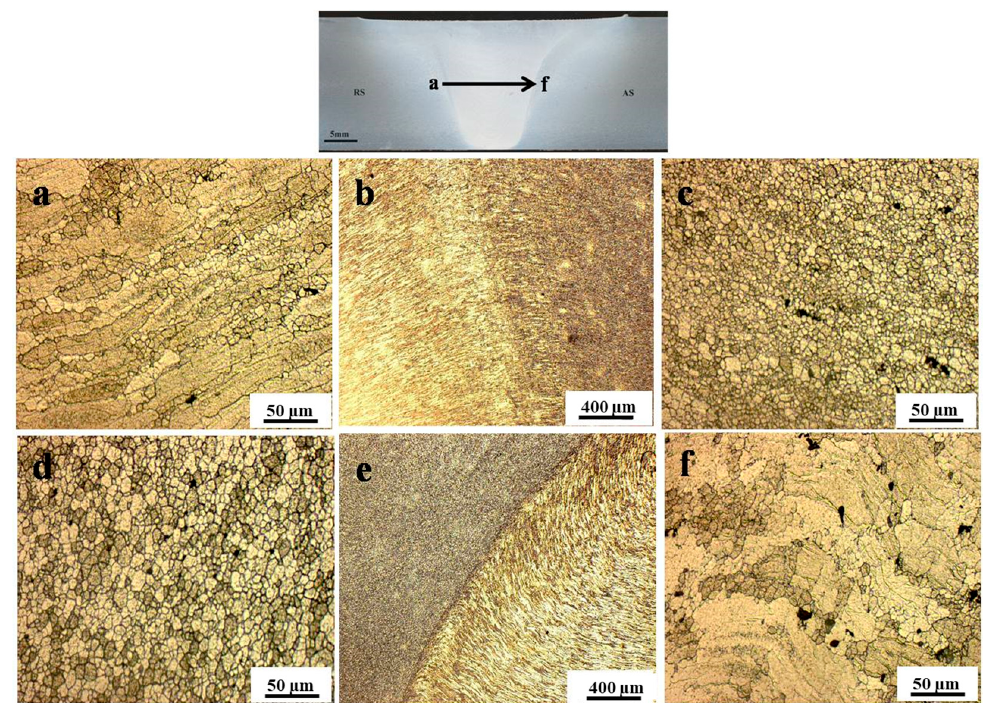
Figure 6. Optical microstructure across the weld area along the indicated arrow in the optical macrograph of FSWed AA7075-T6. ( a , b ) TMAZ–NG RS interface, ( c , d ) NG, and ( e , f ) TMAZ–NG AS interface.